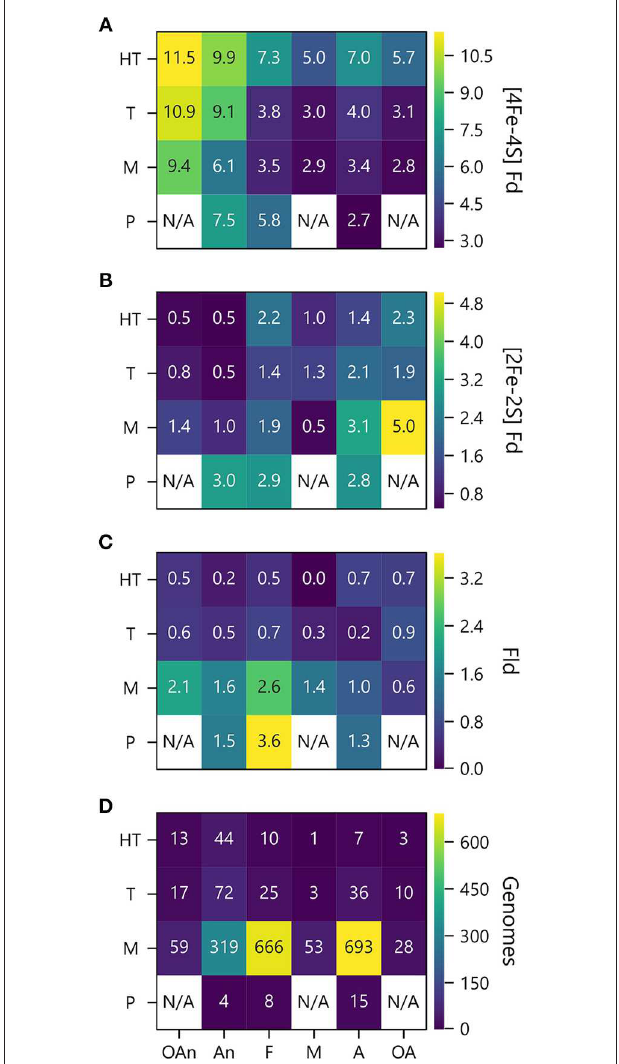
FIGURE 7 | PEC counts sorted by temperature and oxygen niche. The average numbers of (A) [4Fe-4S] Fd (B) , [2Fe-2S] Fd, and (C) Fld gene counts per genome are plotted as a function of O 2 requirement and optimal growth temperature. (D) Genome counts from each environmental niche are plotted as a function of O 2 requirement and optimal growth temperature. O 2 requirements shown on the x axis are abbreviated as obligate anaerobe (OAn), anaerobe (An), facultative (F), microaerophilic (M), aerobic (A), and obligate aerobic (OA). Growth temperatures shown on the y axis are abbreviated as hyperthermophile (H), thermophile (T), mesophile (M), and psychrophile (P). N/A denotes not applicable when organisms were not